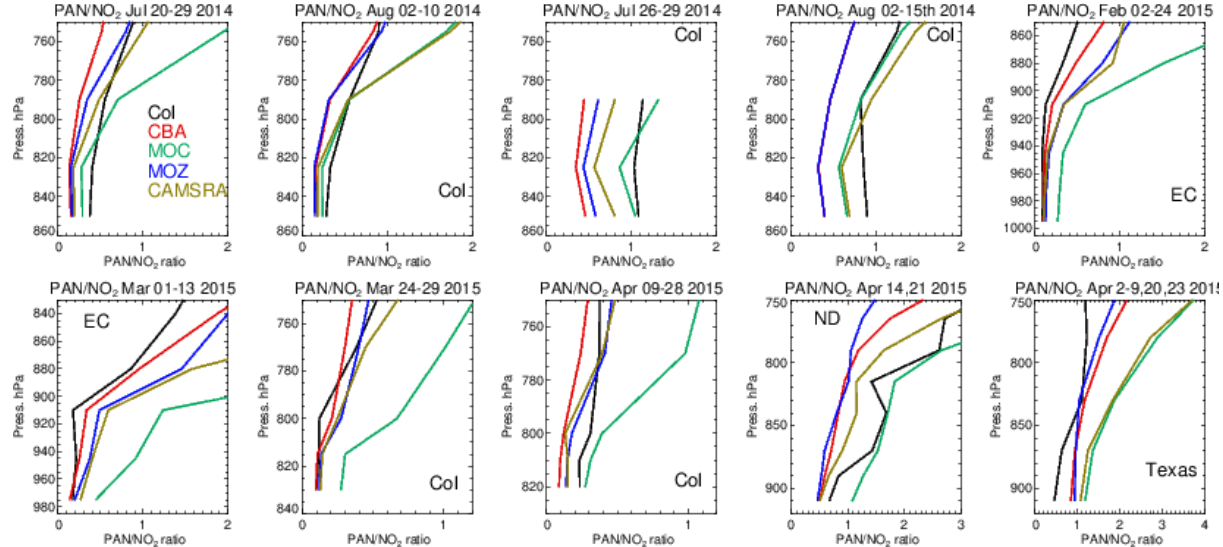
Figure 19. Comparisons of the ratio of [ PAN ] / [ NO 2 ] derived from the corresponding mean values derived during each aircraft campaign. Campaigns shown (top left to bottom right) are DISCOVER-AQ, FRAPPE, WINTER and SONGNEX.